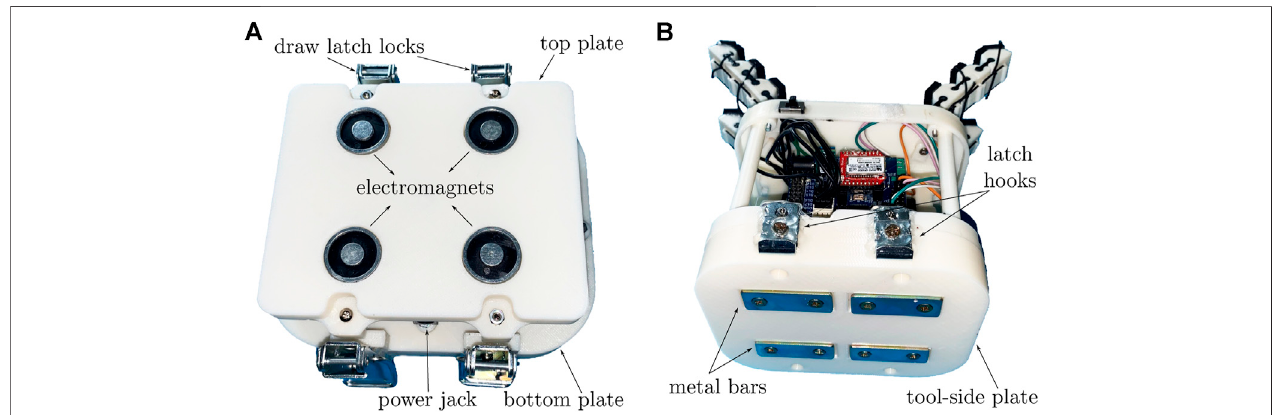
FIGURE4|(A) Magneticplatformthatconstitutesthemaster-sideofthepresentedtoolchanger. (B) LightversionoftheCo-Gripper(Salviettietal.,2018)withtool- side plate embedding metal bars and latch hooks.